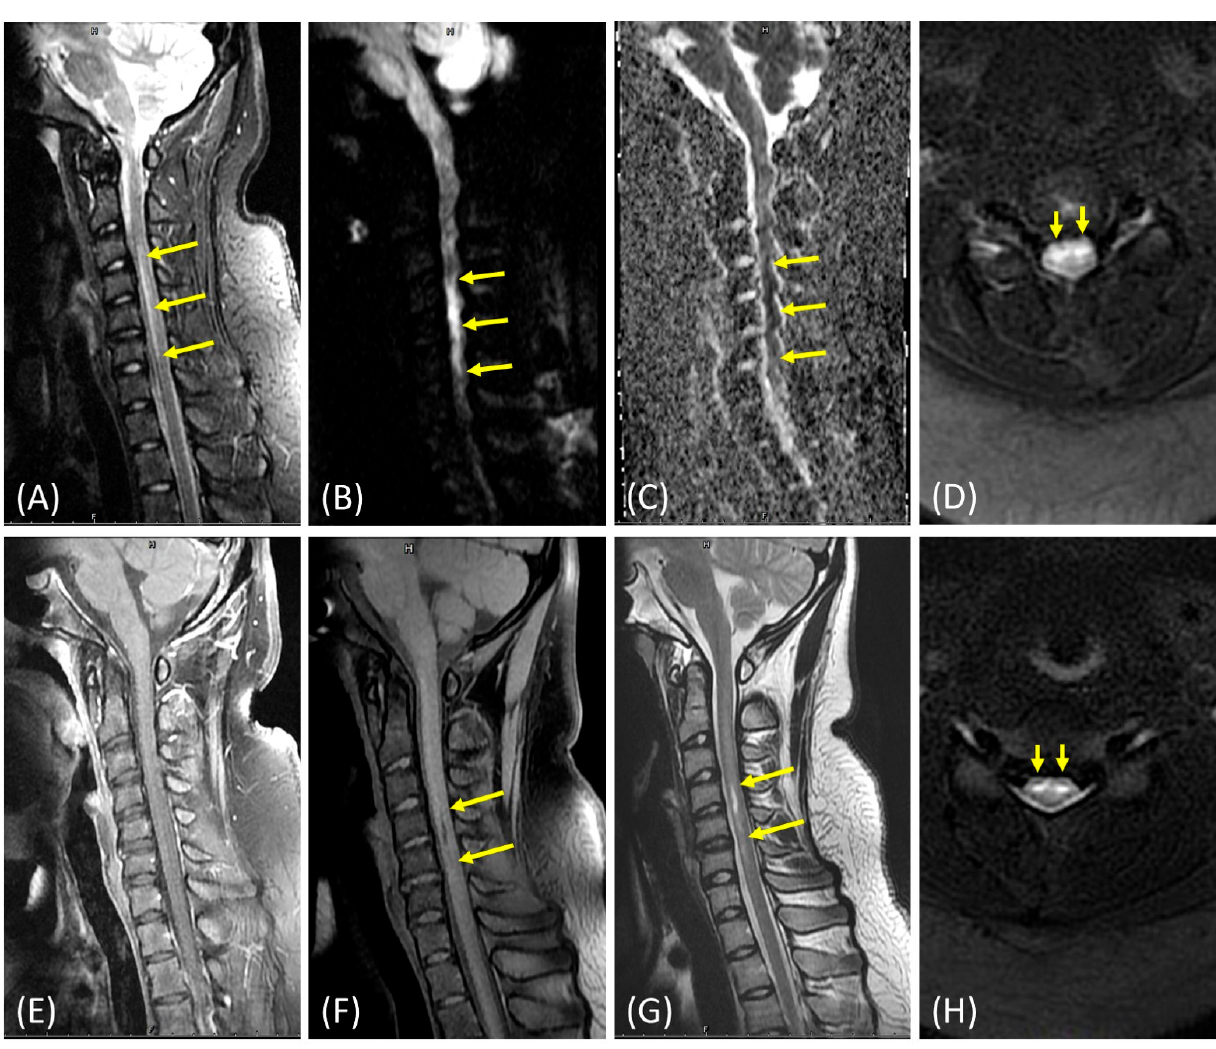
Figure 1. MRI reveals a hyperintensity in the patient’s cervical spinal cord between cervical vertebrae C3-6 on sagittal STIR images ( A ), which are associated with restricted diffusion abnormalities in the patient’s sagittal DWI ( B ) and apparent diffusion coefficient (ADC) images ( C ). Symmetrical elevated intramedullary signals in the anterior horns of the patient’s spinal cord (i.e. the “owl-eyes” sign for spinal cord infarction) were observed in the axial STIR images. Edema was also present at the same spinal cord level ( D ). No internal enhancements were detected in the sagittal T1-weighted contrast- enhanced images, which is inconsistent with the presence of infection and/or inflammation ( E ). A three-month follow-up MRI revealed a hypointensity between cervical vertebrae C4-5 in the patient’s sagittal T1-weighted fat-saturated (T1FS) images ( F ) and a hyperintensity in the sagittal T2-weighted images ( G ) due to myelomalacia. Axial STIR images ( H ) show a T2-hyperintensity in the anterior grey columns, in which the owl-eyes characteristic sign is observed as well. Arrows indicate the presence of